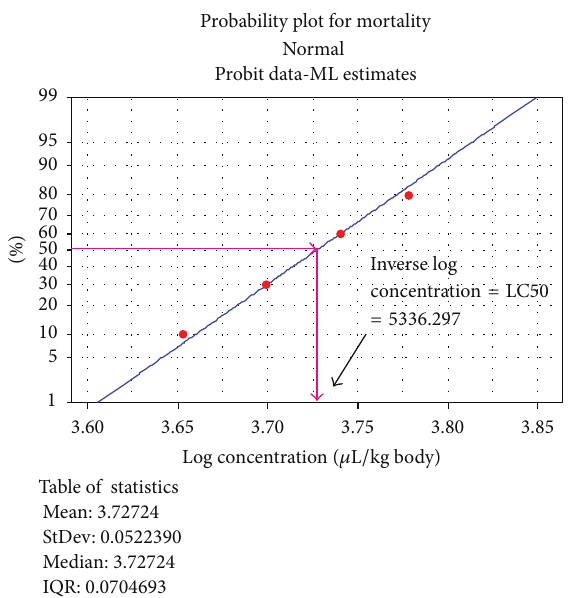
Figure 2: Probit transformed responses of mice treated with differ- entconcentrationsof T.ammi